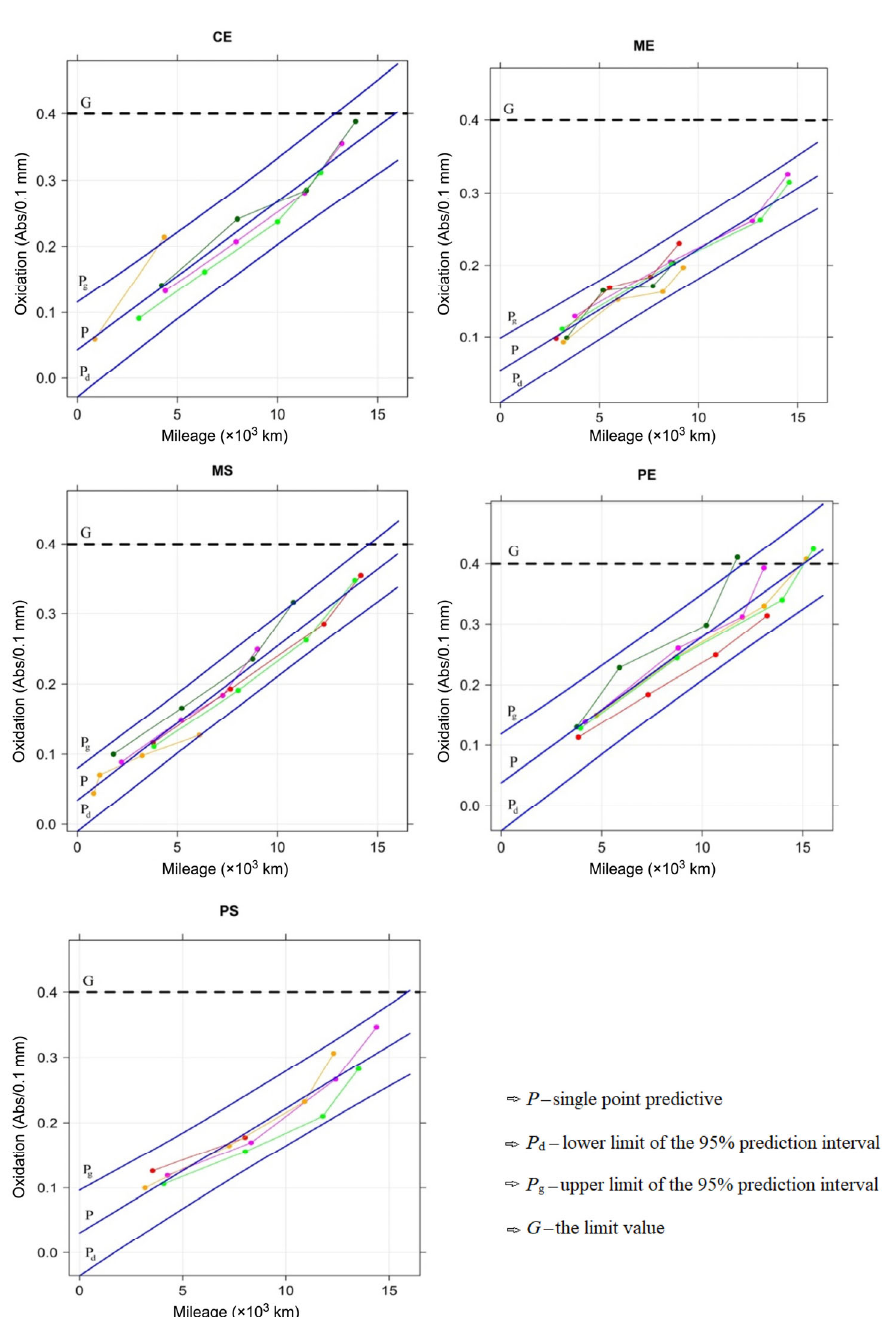
Fig. 3 Observed data and model predictions for mileage from zero to 16 thousand